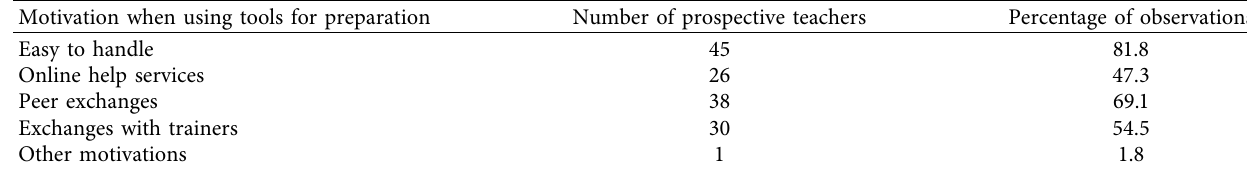
Table 10: Motivations for choosing the tools during group preparation.